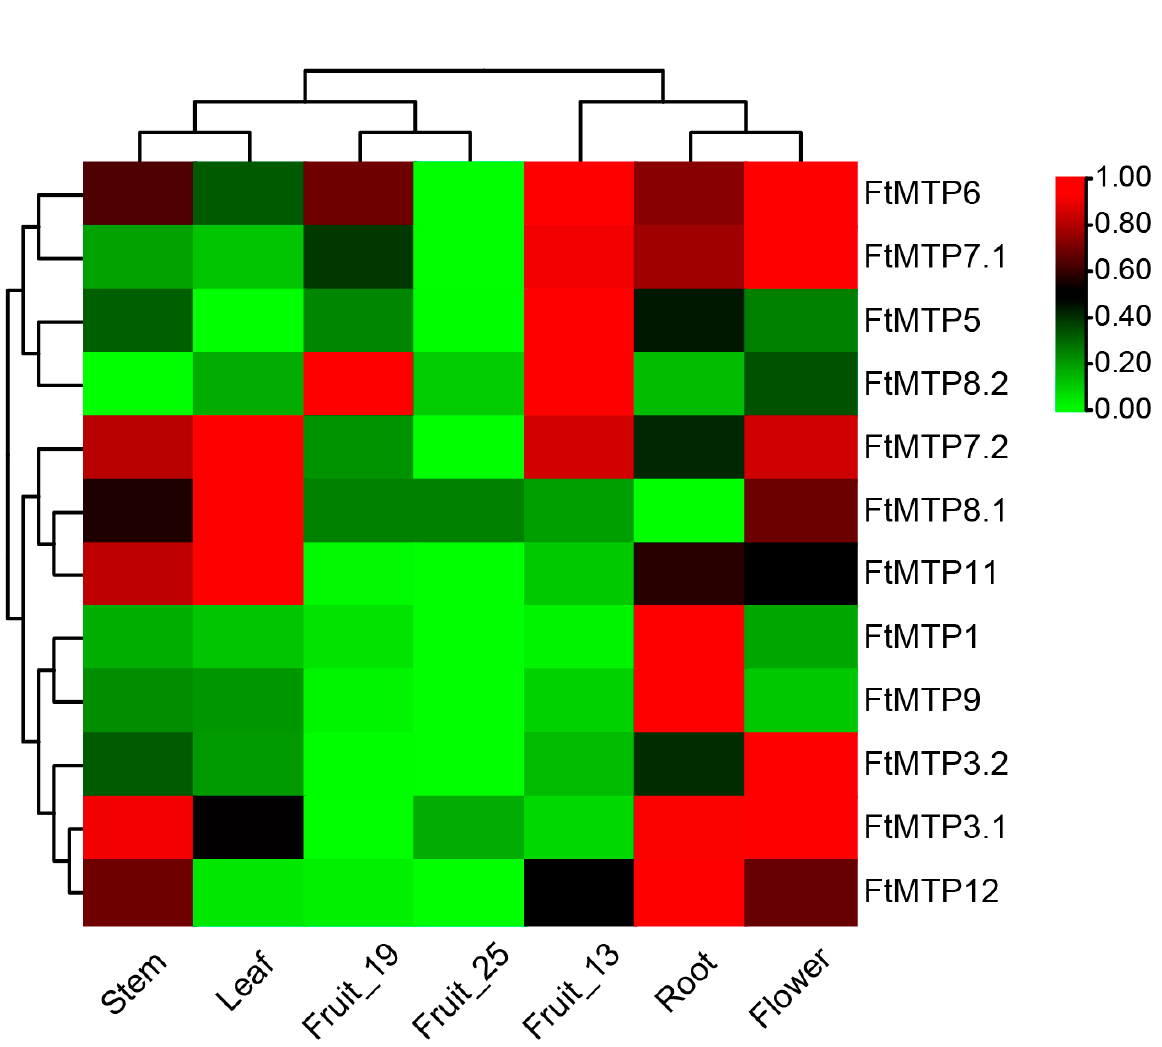
Figure 5. Heatmap analysis of the expressions of FtMTP s in different Tartary buckwheat tissues at different developmental stages. Gene expression (FPKM) was normalized and visualized using the TBtools software. The Stem, Leaf, Fruit_19, Fruit_25, Fruit_13, Root, and Flower marked in the figure represented the stem, leaf, fruit at 19 days of development, fruit at 25 days of development, fruit at 13 days of development, root and flower of Tartary buckwheat,